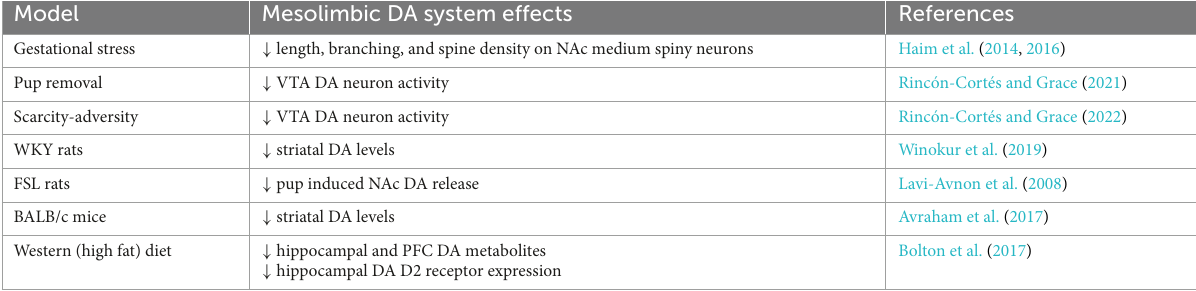
TABLE 1 DA system dysregulation in rodent models relevant to PPD.